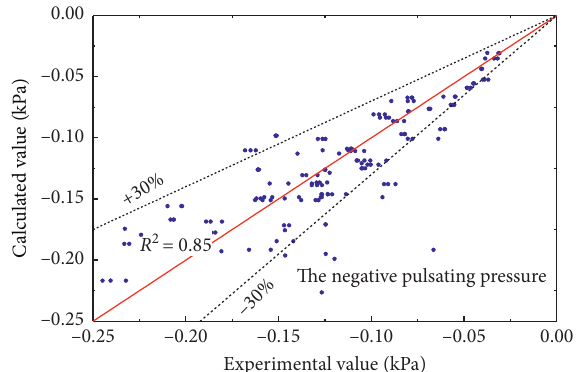
Figure 15: Experimental negative dynamic pressure versus cal- culated results.